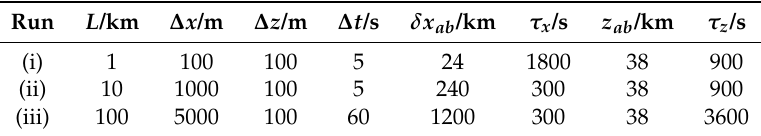
Table 2. Parameters for the numerical simulations: mountain width L , spatial increments ∆ x and ∆ z in the horizontal and vertical directions, time step ∆ t , thickness δ x ab and time scale τ x of the horizontal and altitude z ab and time scale τ z of the vertical